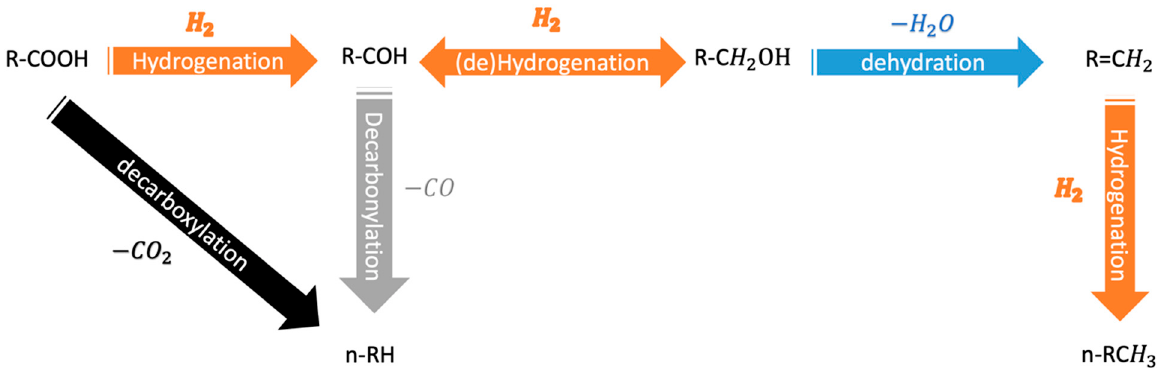
Figure 2. Hydrodeoxygenation reaction network. The HDO reaction can happen by two possible approaches: direct HDO and two-step HDO. In the first process, unsaturated bonds are hydrogenated using the high pressure of H 2 (100 bar, ~573 K); separation of hydrogen from green diesel follows. Downstream, green diesel is separated from molecules such as excess hydrogen, water, CO 2 , as well as an amount of C2-C3 alkanes. Dehydration of glycerol (co-product) follows [19]. Higher capital costs are involved in the latter case and lesser hydrogen consumption. The direct HDO has higher H 2 consumption due to oxygen removal from glycerol backbone towards propane formation. The co-product amount in the second process is much higher